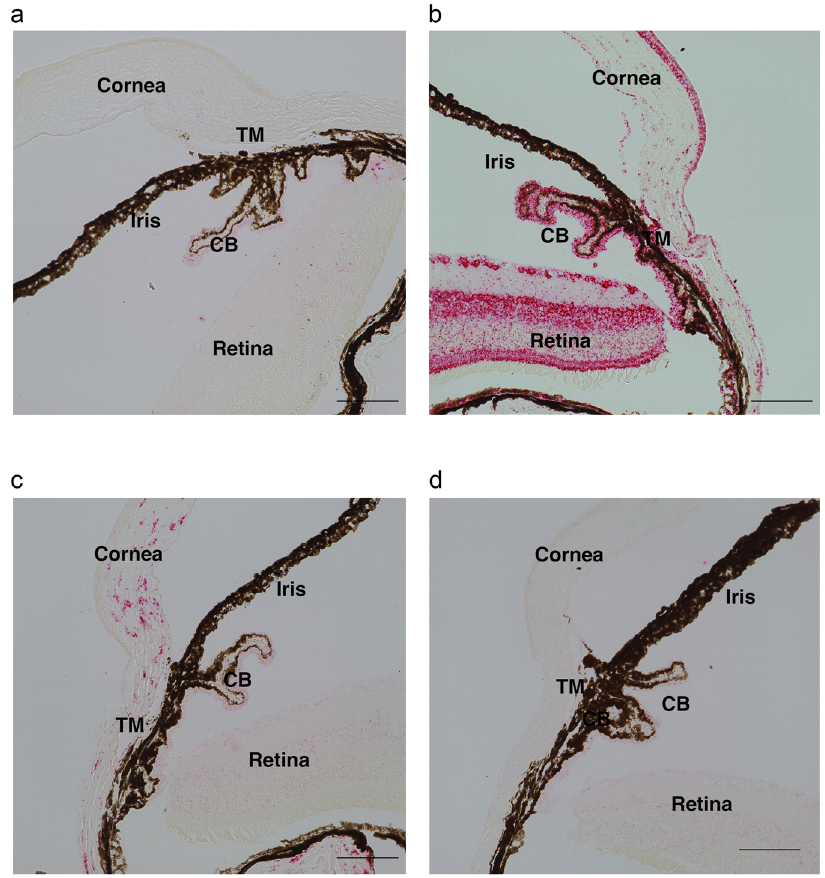
Fig. 7 In situ characterization of Angptl7 mRNA in WT and Angptl7 KO mouse eyes. Angptl7 mRNA was not expressed in any ocular tissue in Angptl7 KO mice whereas it was expressed in TM, cornea, and sclera of WT mice as shown by in situ hybridization (RNAscope). Bright fi eld images showing following probes. a Negative control: DapB. b Positive control: Ubc (red). c WT mice: Angptl7 (red), and ( d ) Angptl7 KO mice: Angptl7 (no signal). Scale bars represent 100 μ